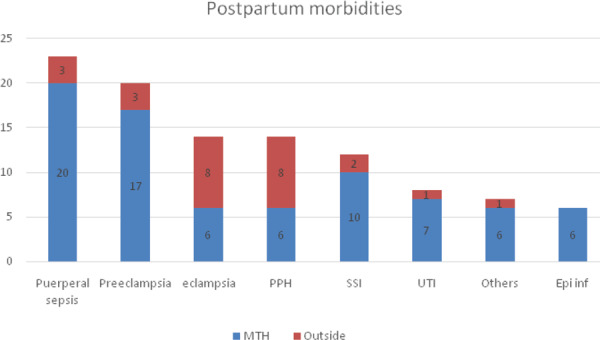
Distribution of postpartum morbidities